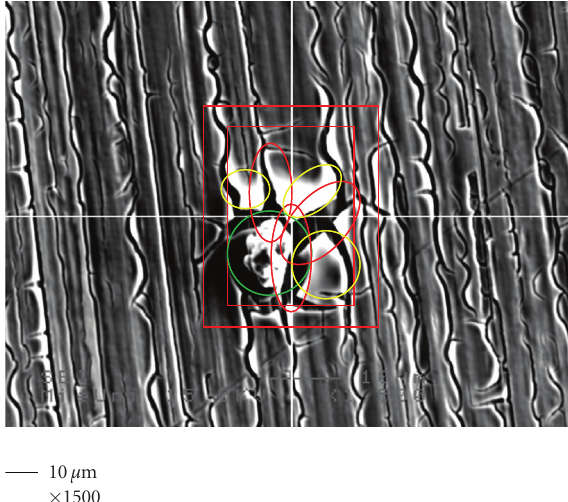
Figure 3: SEM image of Cr-doped TiO 2 film prepared under the condition of R = 1 wt%.